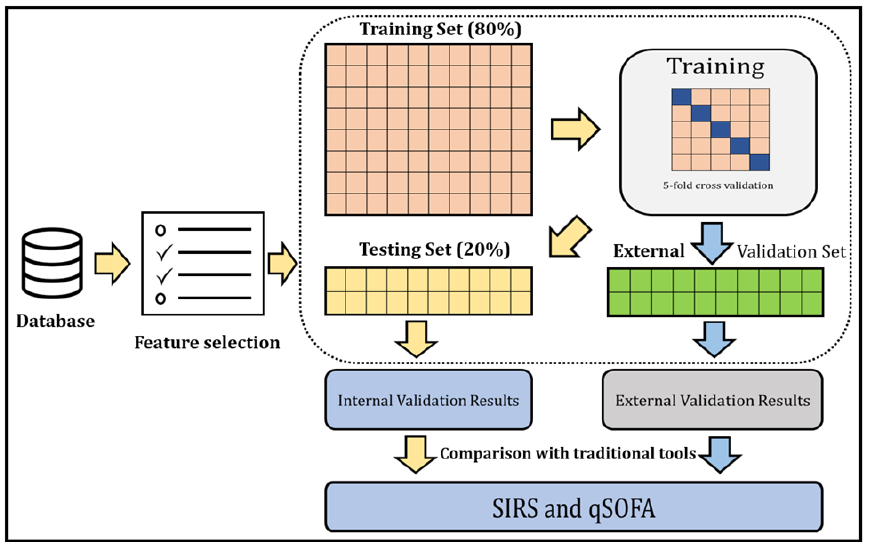
Figure 1. A general outline of the step-by-step approach to identify sepsis patients and compare the identification with traditional tools.